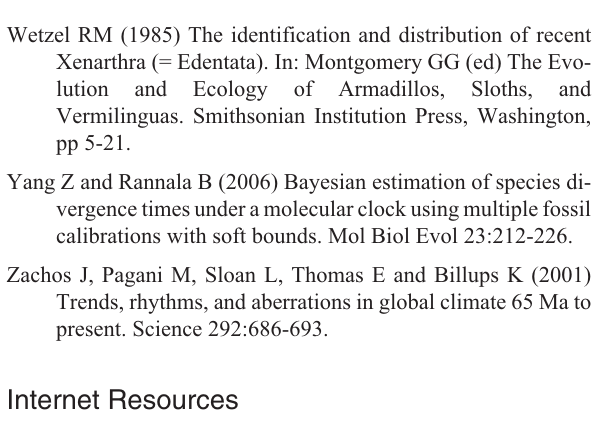
Table S2 - List of fossils used as soft calibration